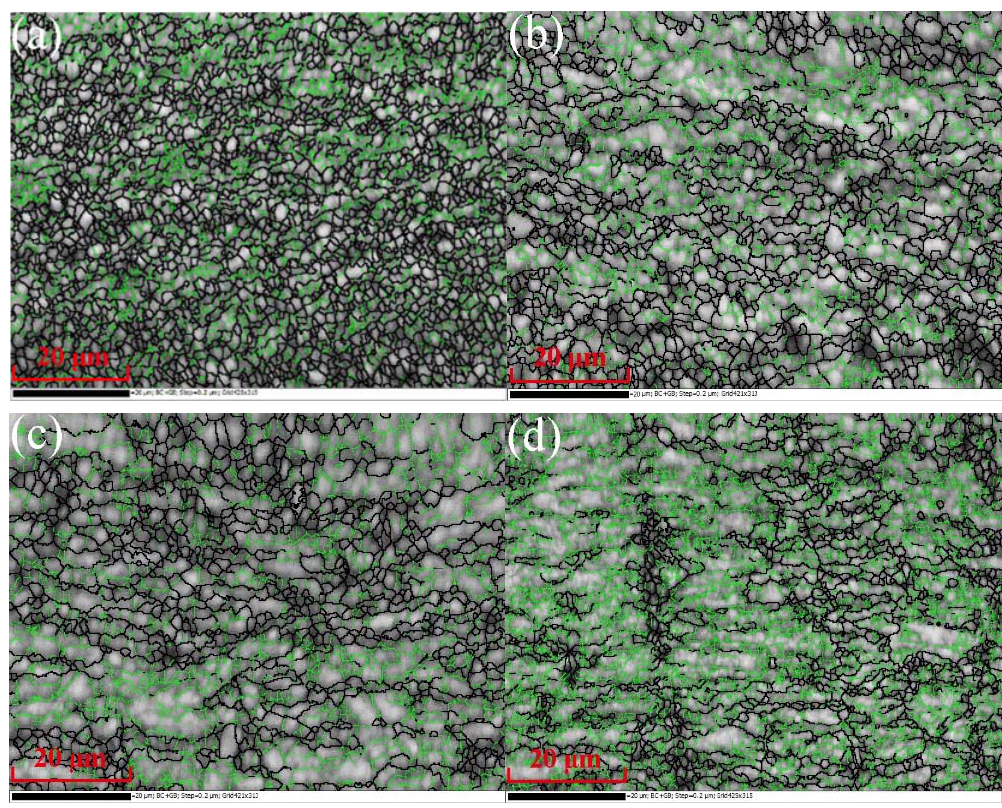
Figure 4. Grain misorientation distributions of 6061 aluminum alloy. ( a ) MEM; ( b ) MEE; ( c ) 3 ‐ pass of ECAP; ( d ) 3 ‐ pass of MAC.